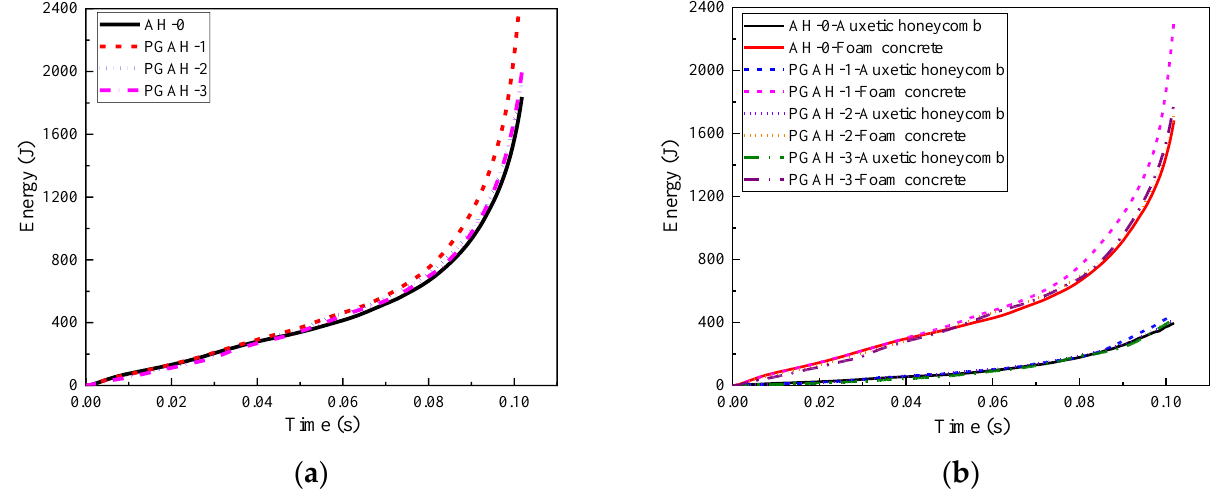
Figure 14. The time history of absorbed energy (1 m/s): ( a ) foam concrete filled auxetic honeycombs; ( b ) foam concrete and auxetic honeycomb.